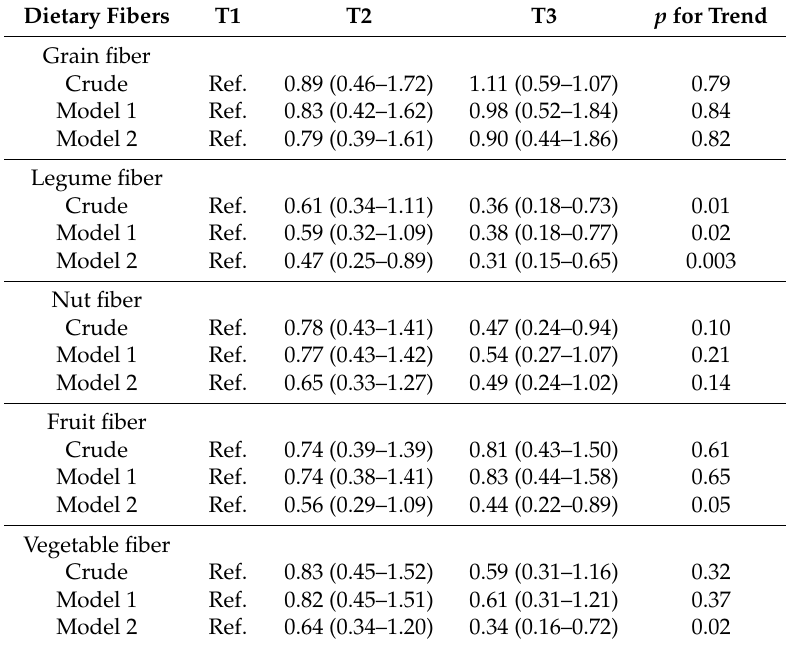
Table 3. The hazard ratio (95% CI) of coronary heart disease across tertiles of dietary fiber and its